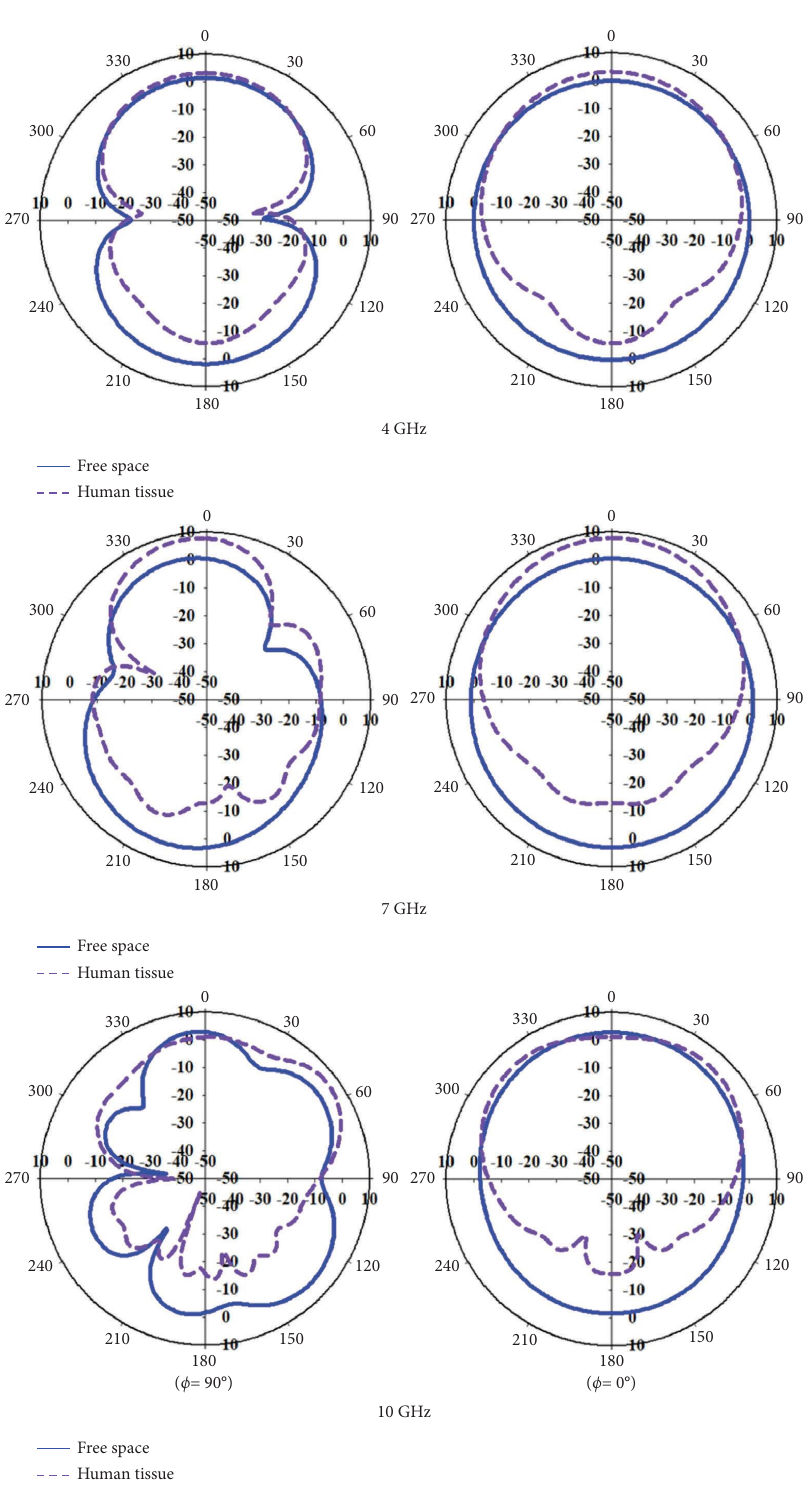
Figure 12: Radiation patterns of the proposed MIMO